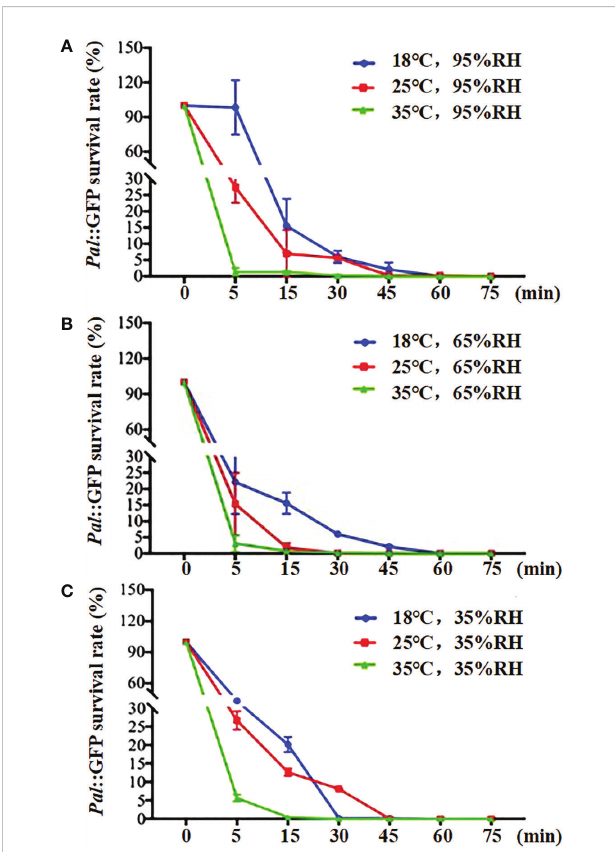
FIGURE 3 Effect of temperature and relative humidity (RH) on the survival rate of Pseudomonas amygdali pv. lachrymans ( Pal ) in the aerosol chambers. (A) 95% RH, (B) 65% RH and (C) 35% RH. The survival rates of Pal ::GFP aerosol were determined at 0, 5, 15, 30, 45, 60 and 75 min after aerosolization, respectively. Error bars represent the standard deviations (SDs) of three